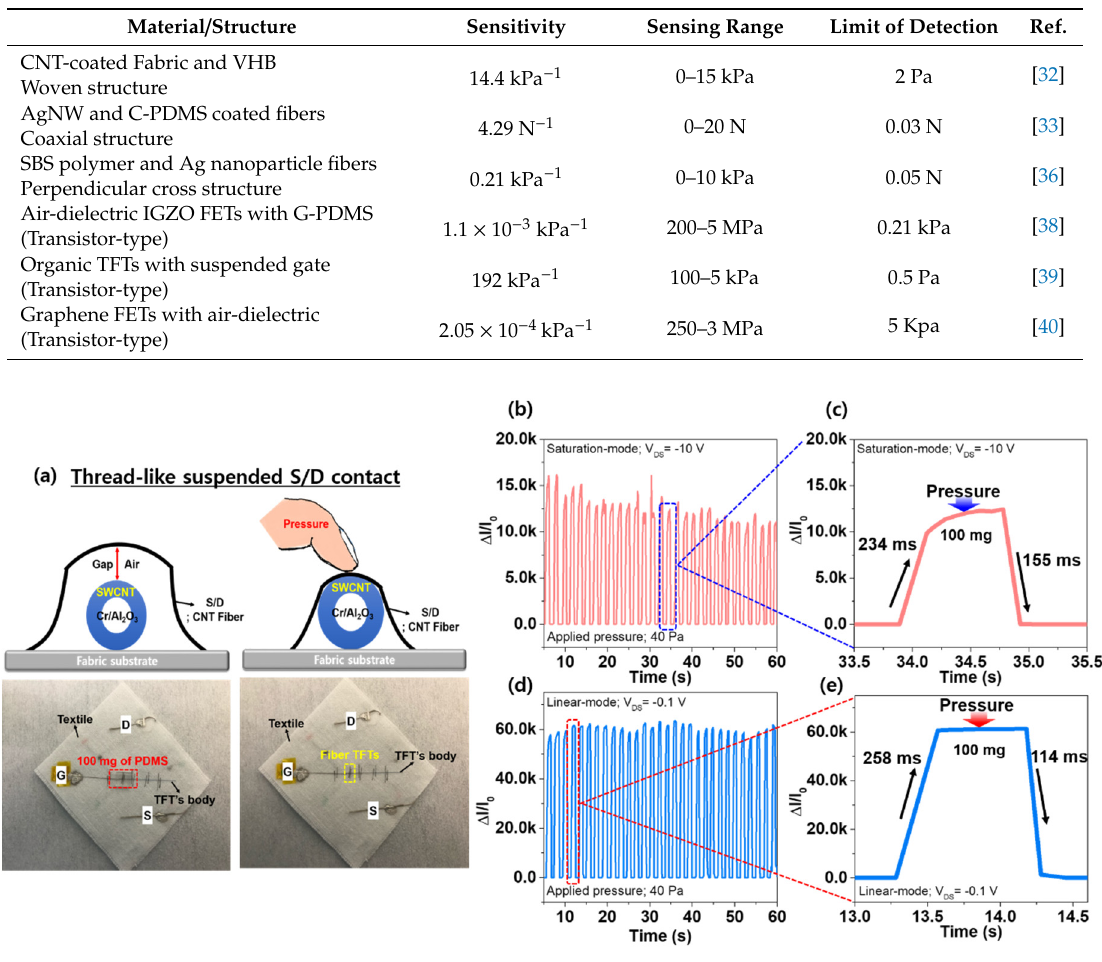
Table 1. Comparison of the sensing performances of the fiber and transistor-type pressure sensors.